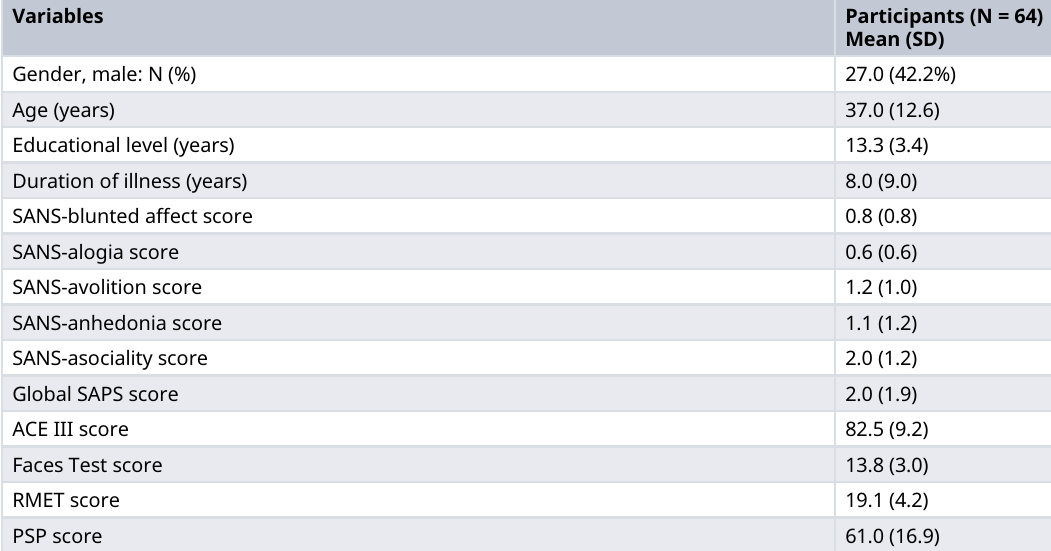
Table 1. Characteristics and descriptive statistics of variables used in the network